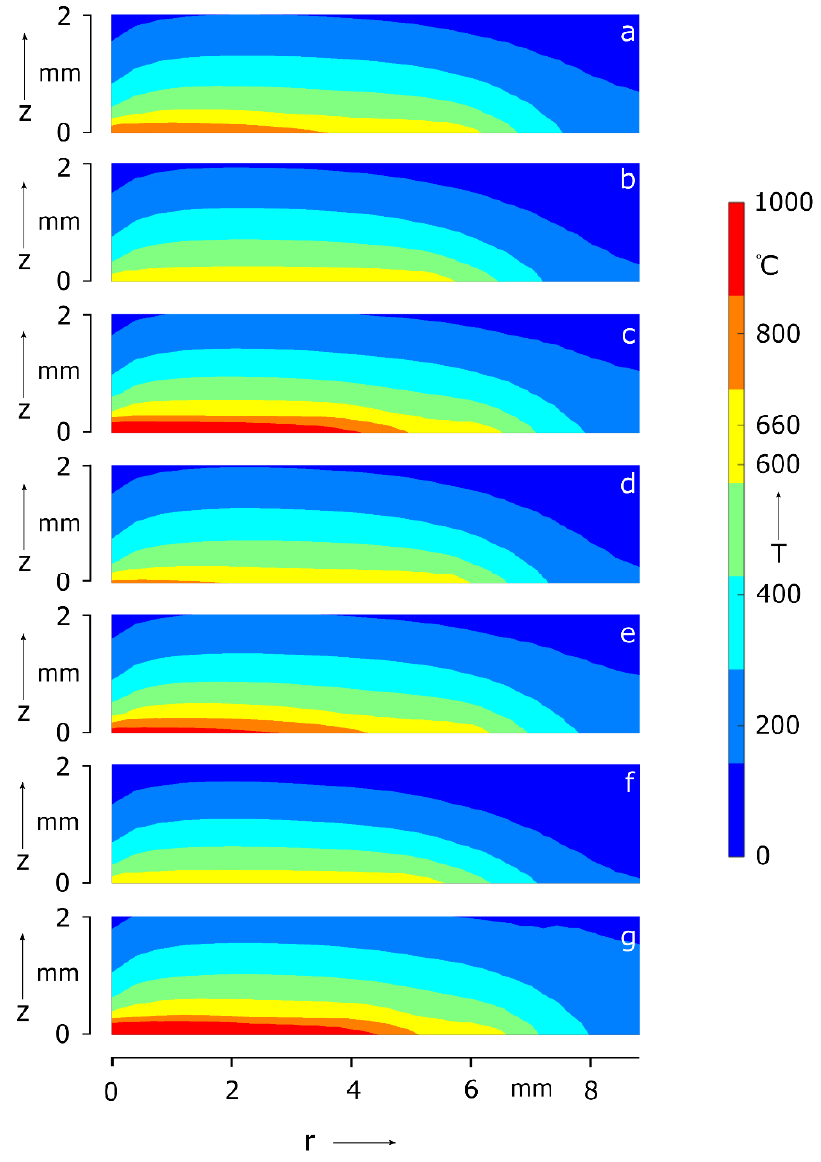
Figure 1. reference spot weld ( a ) and spot welds for varying voltage ( b , c ), contact resistance ( d , e ) and welding time ( f , g ).